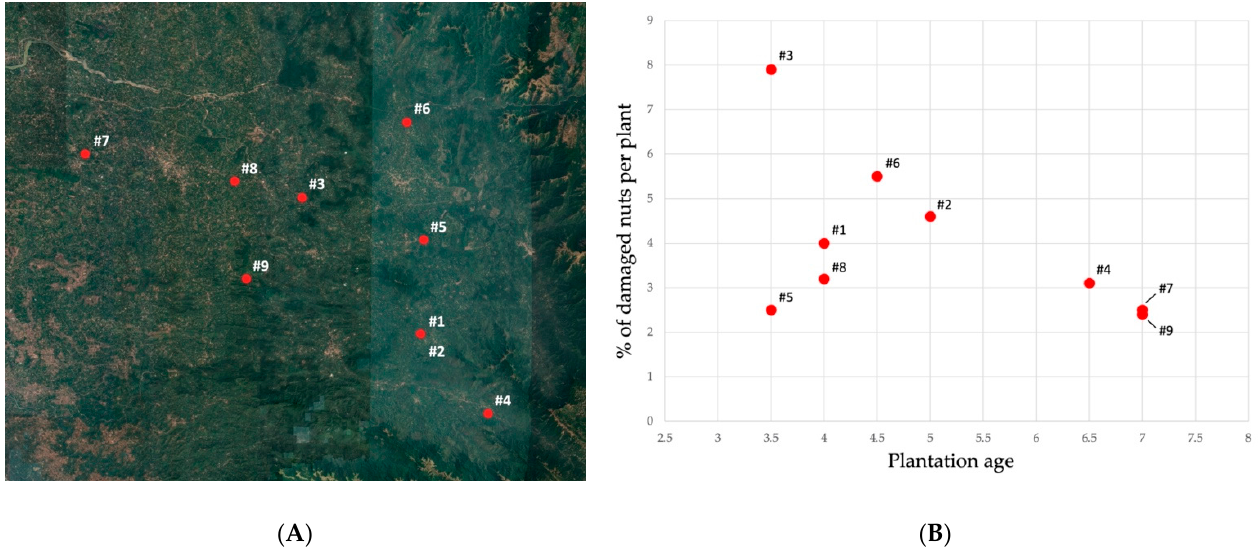
Figure 6. ( A ) Map of the plantations presenting damages caused by X. crassiusculus , numbered following the order given in Table 1; ( B ) Plot illustrating the percentage of the damaged nuts on infested plants in association with the age of the areca palm plantation. Table 1. Localities where X. crassiusculus attacks were recorded during the survey in association with damage incidence.